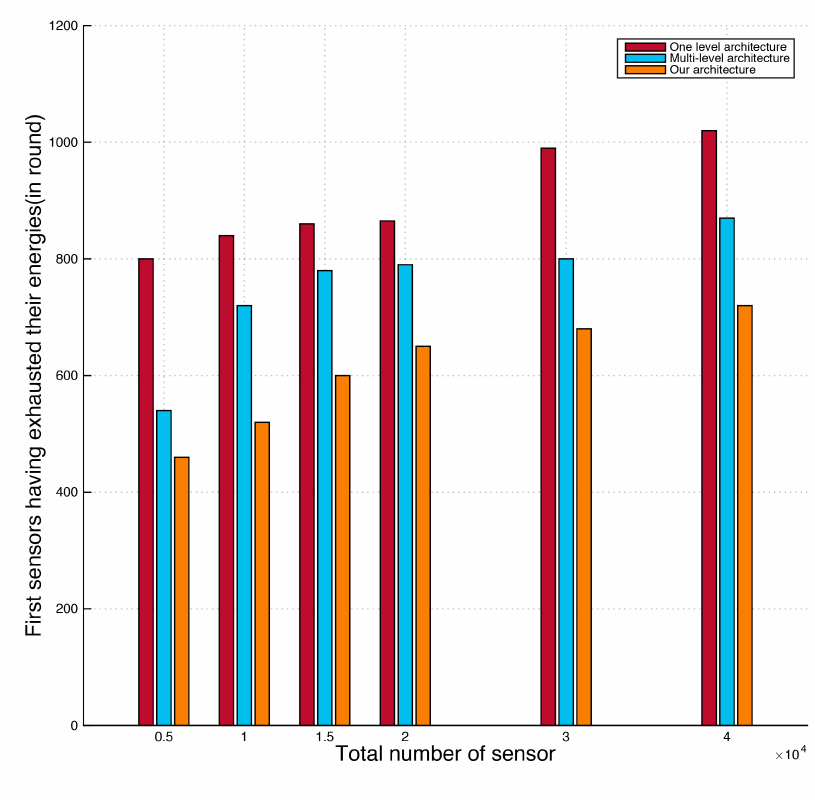
Figure 9. Instant of the first sensors having exhausted their energy following the LEACH.